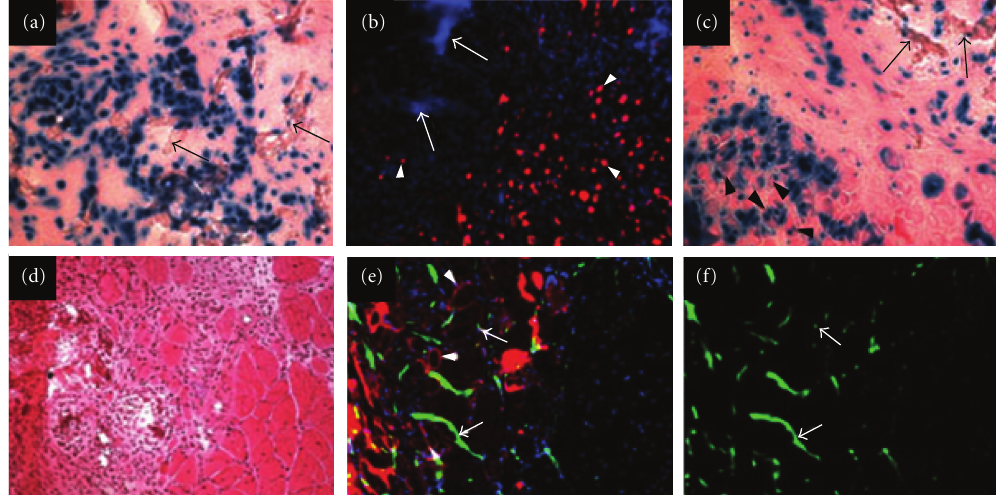
Figure 5: LacZ and eosin staining 1 month after implantation revealed that numerous LacZ + myoblasts were able to survive within the implanted muscle graft region ((a) and (c)) . Residues of nondegraded sca ff old were also visualized within the implanted muscle graft area ((c), arrowheads ). LacZ + myoblasts were seen forming multinucleated myotubes within the implanted area ((a) arrows ). Desmin positive myoblasts ((b) arrowheads ) were detected within the vicinity of nondegraded portions of the sca ff old ((b) arrows ). An H&E staining revealed newly formed myofibers within the implantation site (d). Dystrophin-positive myofibers ( red, arrowheads ) were detected 1 month after implantation (e) as well as CD31-positive cells, ((e) and (f), green